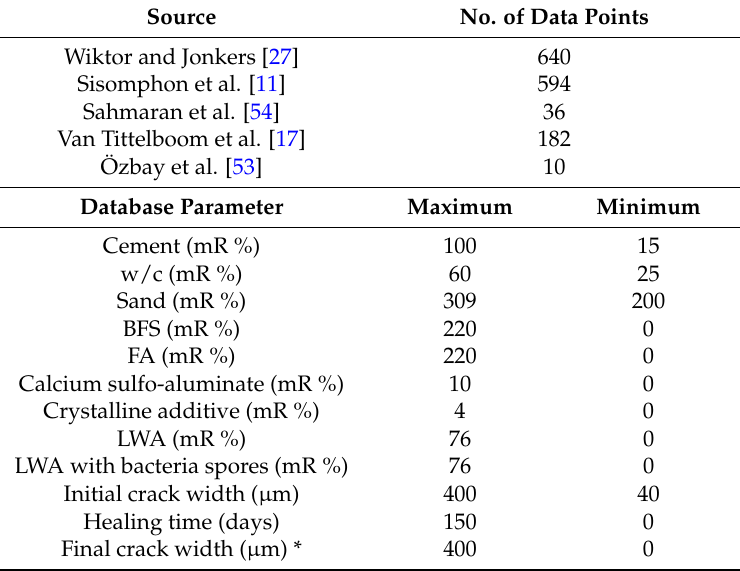
Table 2. Database sources and range of input and output